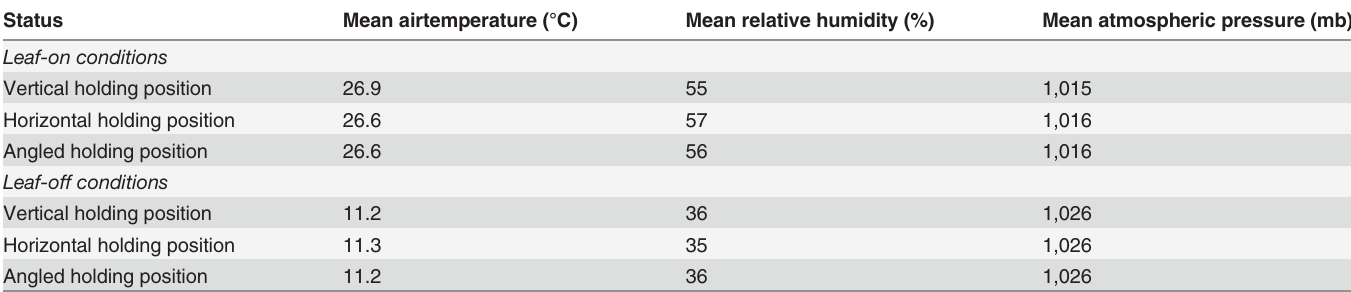
Table 2. Mean environmental conditions during data collection with the Flint GNSS receiver in the deciduous stand.